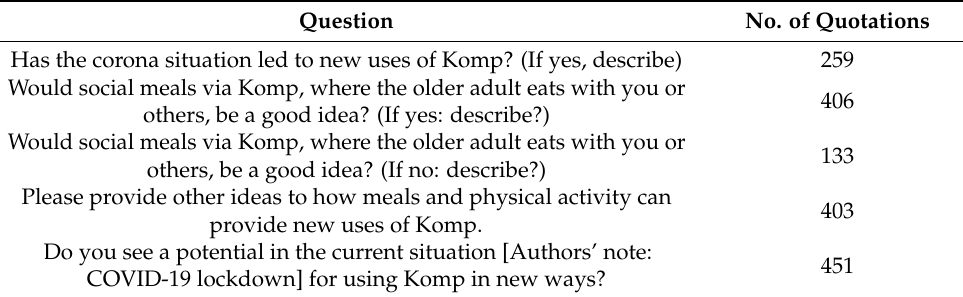
Table 1. Number of free-text responses to questions in the survey. Question No. of